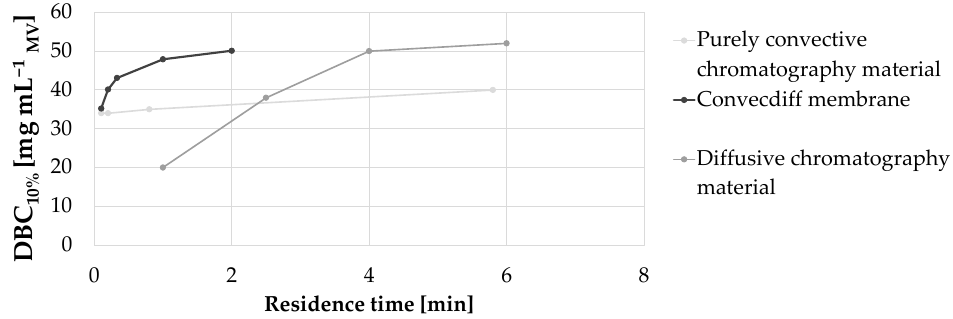
Figure 6. DBC 10% as a function of residence time for several commercially-available materials and the convecdiff membrane prototype. The convecdiff membrane prototype (1.2 mL MV and 4 mm bed height), as well as some of the other membranes/materials were tested internally. All other data points are taken from competitor [6,10,11].